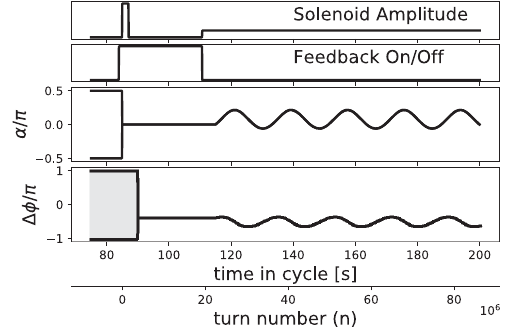
FIG. 2. Principle of the experiment. Δ ϕ can take any value in the shaded region. α is initially (cid:2) π = 2 . The first solenoid pulse tilts the polarization into the horizontal plane. The feedback system is then switched on to set a certain value of Δ ϕ . After that, the solenoid is switched on again at a lower amplitude and the feedback is switched off, leading to